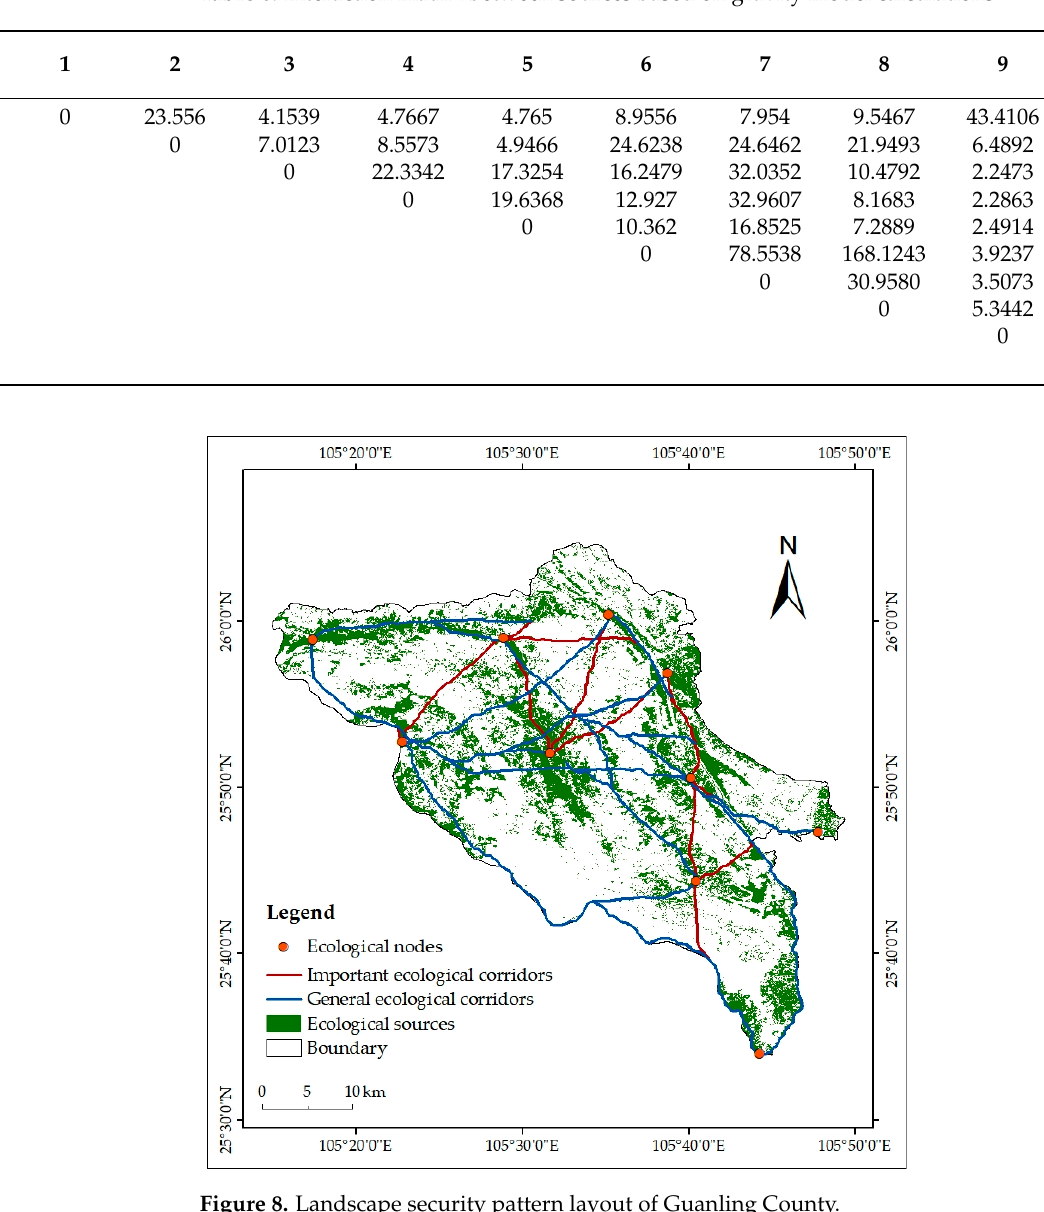
Table 6. Interaction matrix between sources based on gravity model calculations.